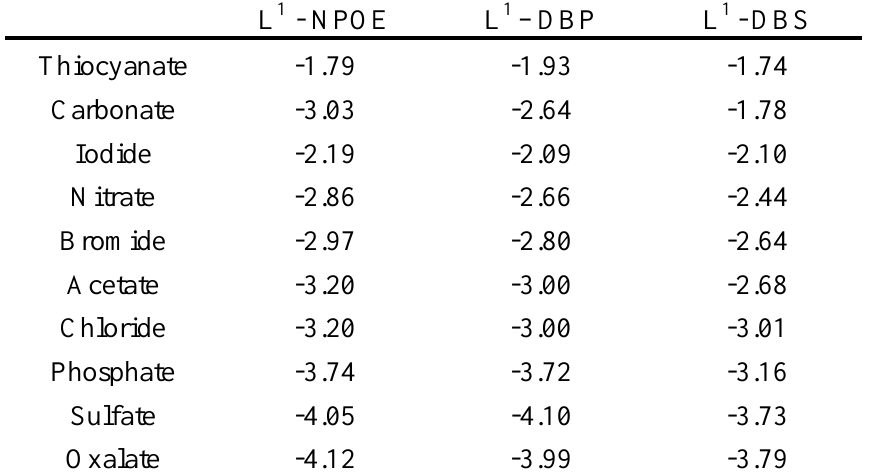
Figure 3. The pH effect on the potential of the membrane electrode containing L 1 , PVC and DBP. Table 2. Potentiometric selectivity for perchlorate selective PVC membranes containing L 1 as ionophore and NPOE, DBP and DBS as